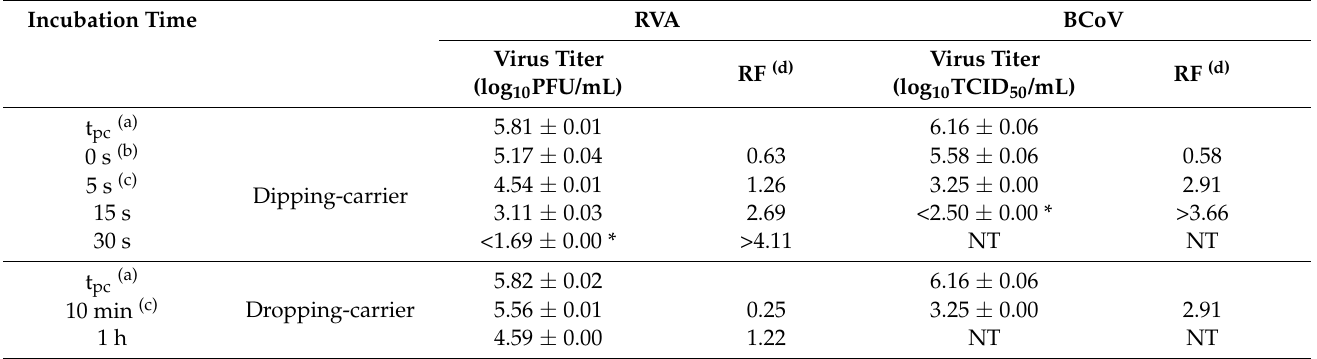
Table 2. Virucidal efficacy of Mix500 toward bovine rotavirus A (RVA) and bovine coronavirus (BCoV) in rayon sheet